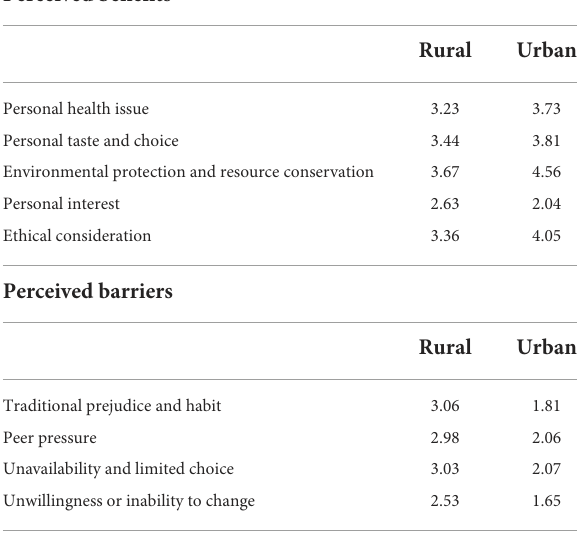
TABLE 10 Perceived benefits and barriers to vegetarianism between rural and urban